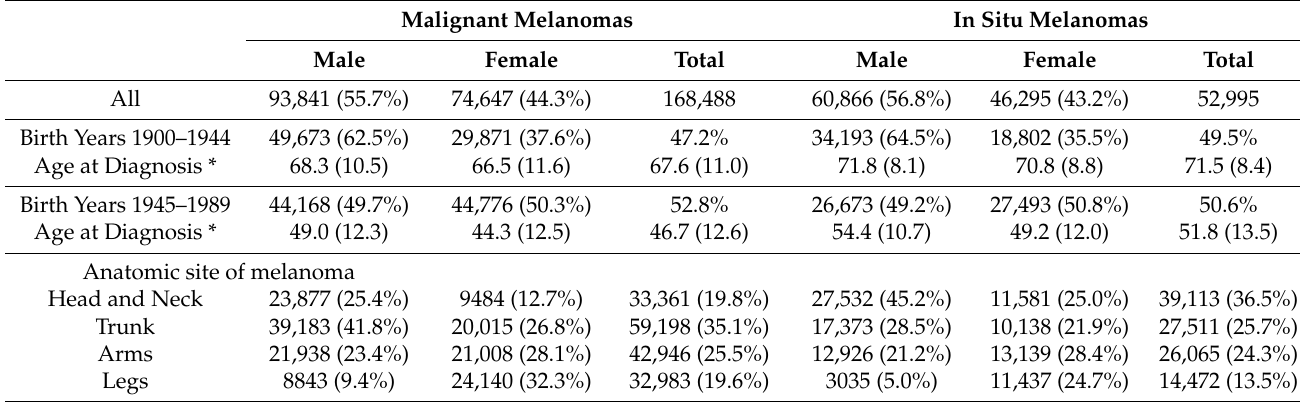
Table 1. Cases of melanoma among White individuals in the United States born from 1900 through 1989 aged 15–84 years. Data from SEER 9,